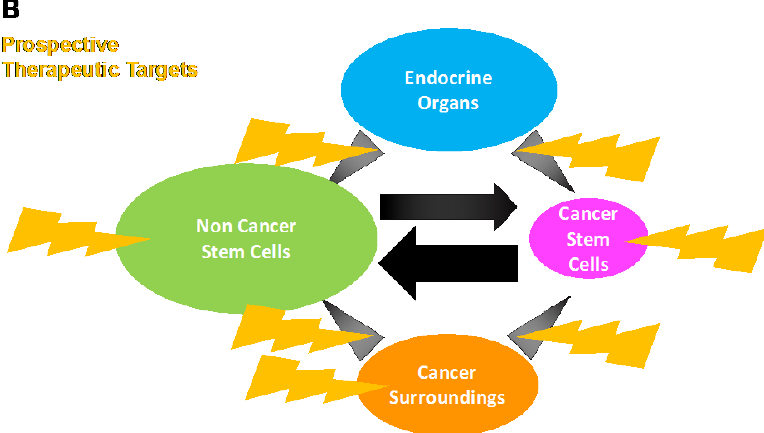
Figure 2. Conventional and prospective targets in cancer therapy: ( A ) Conventional therapy targets exclusively cancer cells without any distinction of cancer stemness. ( B ) On the other hand, prospective therapy involves microenvironment and endocrine status, which induce cancer stemness. Forced shrinking of cancer stem cell population by alteration of external signals is a possible approach for achieving complete response.